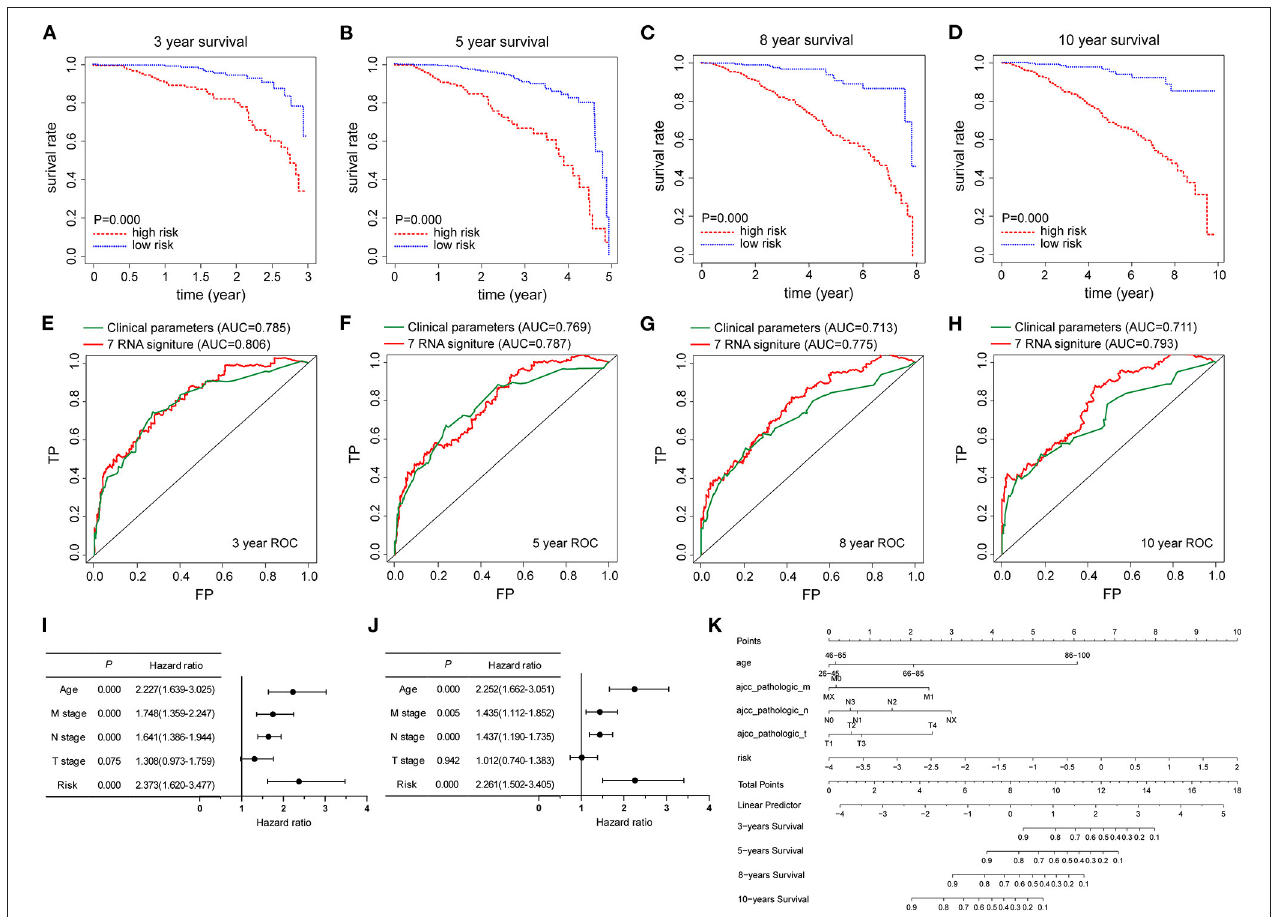
FIGURE 4 | The prognostic capability of pyroptosis-related gene signature in TCGA-BRCA cohort. (A–D) Kaplan-Meier survival curves were employed to compare the differences in survival rates at 3-, 5-, 8-, and 10-years between high-risk and low-risk groups based on the risk score model, respectively. (E–H) Time-dependent ROC curves were used to assess the prognostic value of the risk signature at 3-, 5-, 8- and 10-years, respectively. (I,J) Forest plots of univariate and multivariate Cox regression analysis in TCGA-BRCA cohort, including clinicopathological factors and the risk score model. (K) Nomogram combined with the risk signature and clinicopathological factors. Nomogram to predict the 3-, 5-, 8-, and 10-year survival probabilities of BRCA patients in the TCGA-BRCA cohort based on various clinicopathologic factors, including 7-gene signature risk score, age and tumor